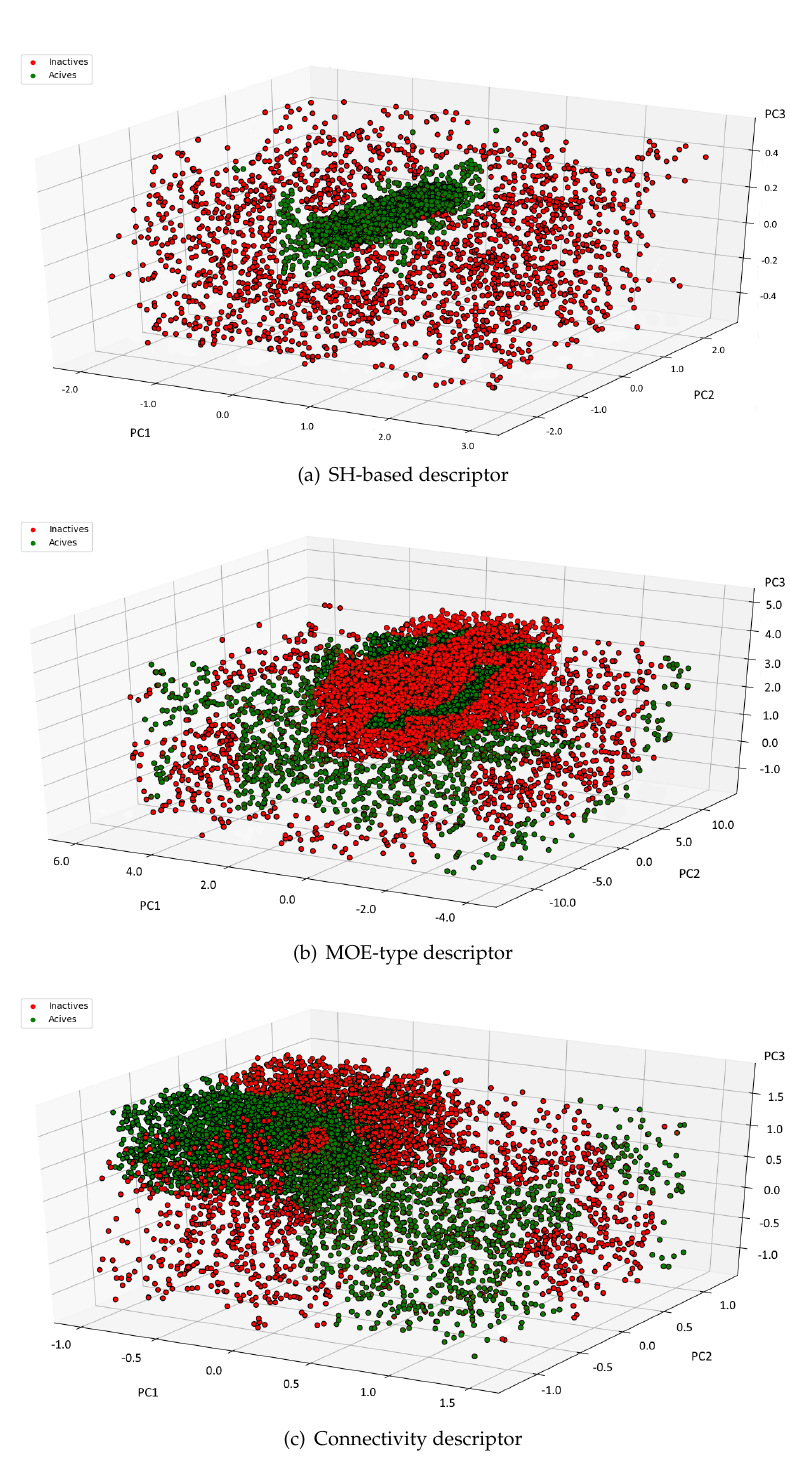
Figure 2. Scattergram of ( a ) Spherical Harmonics-based, ( b ) MOE-type and ( c ) Connectivity descriptor for both active and inactive compounds in P35372